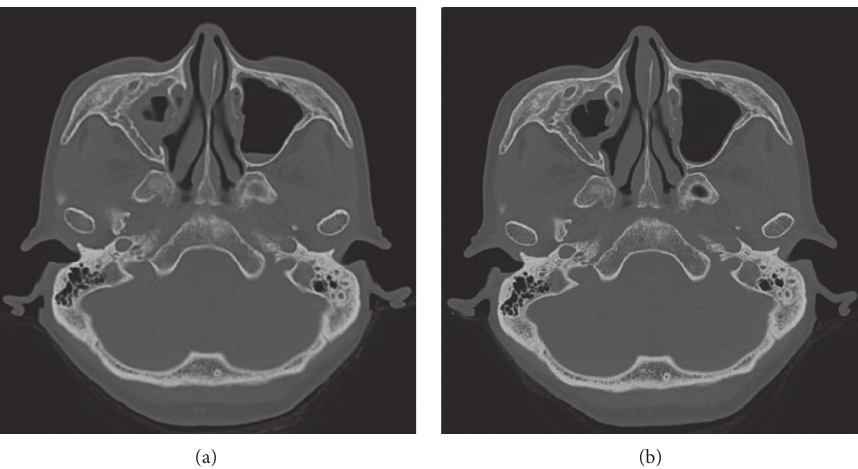
Figure 1: (a) Sinus CT before the administration of mepolizumab. CTshows fluid and mucosal thickening in the maxillary sinuses on both sides, predominantly on the right. (b) Sinus CT in 6 months after the administration of mepolizumab. CT shows a decrease in fluid and mucosal thickening of the maxillary sinuses on both